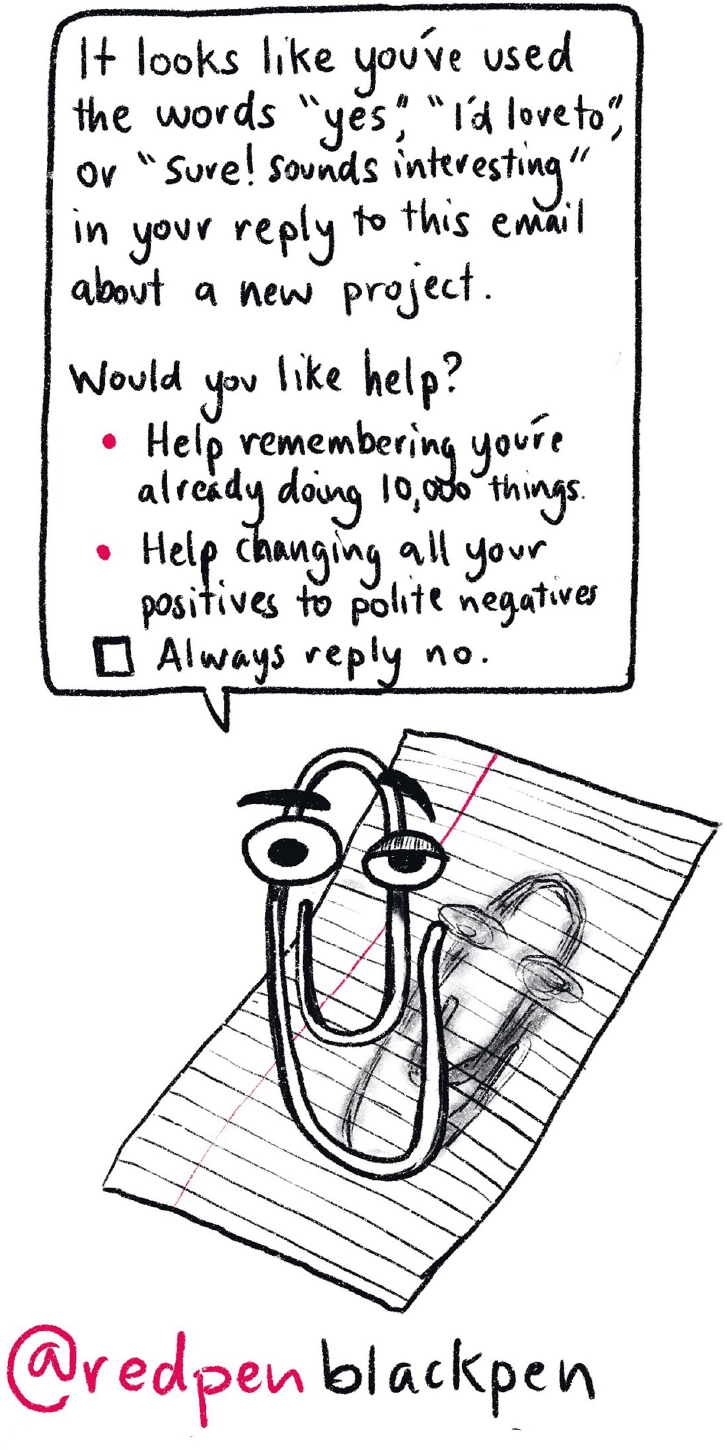
Fig 6. Just say no. The ability to say “no”—even when the opportunity seems exciting—is a must for PIs.